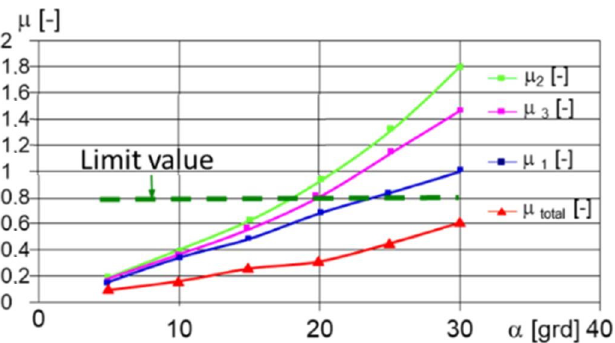
Figure 10. The variation in the µ [ − ] necessary for climbing a slope following the simulation using Equations (15)–(19). For the geometric characteristics of the robot and the total minimum adhesion coefficient, the robot could climb a step under the conditions of a CG (center of gravity of the robot) with a height = 0.20 m.